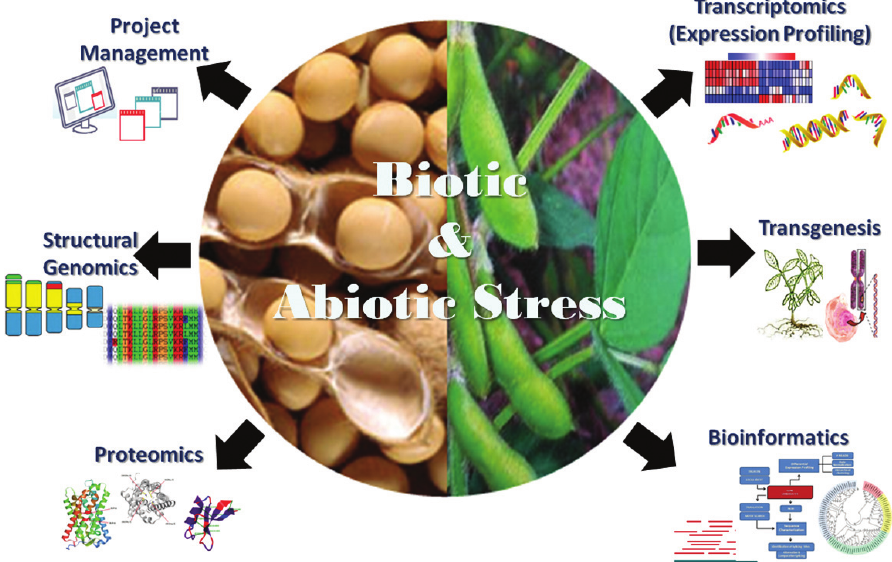
Figure 2 - Functional organization of the GENOSOJA consortium, including six project components, all composed by interinstitutional